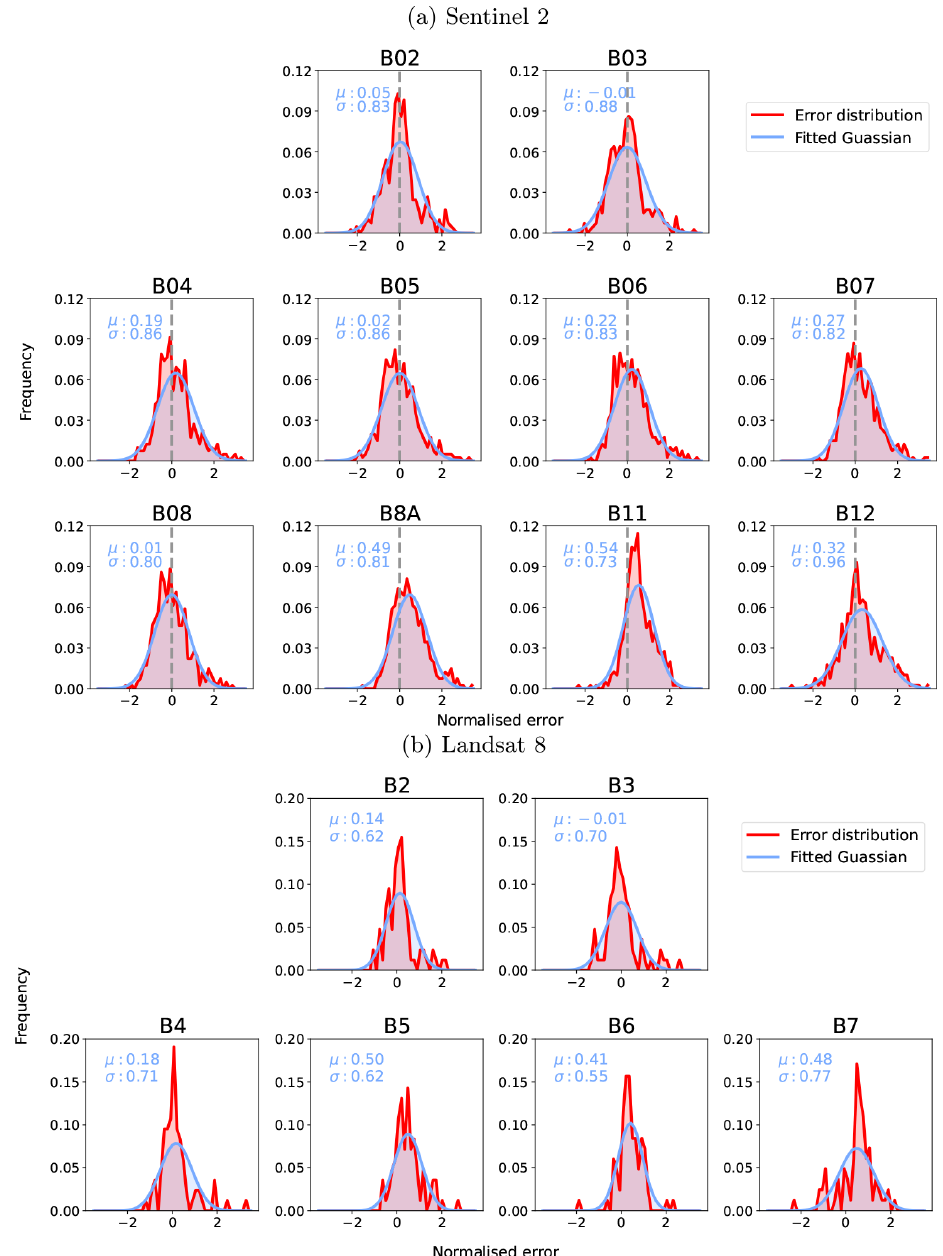
Figure 15. SIAC surface reflectance uncertainty validation. The red histogram distributions show standardised error distributions (Error distribution) from the data and the blue ones the estimated Gaussian distribution from the distributions (Fitted